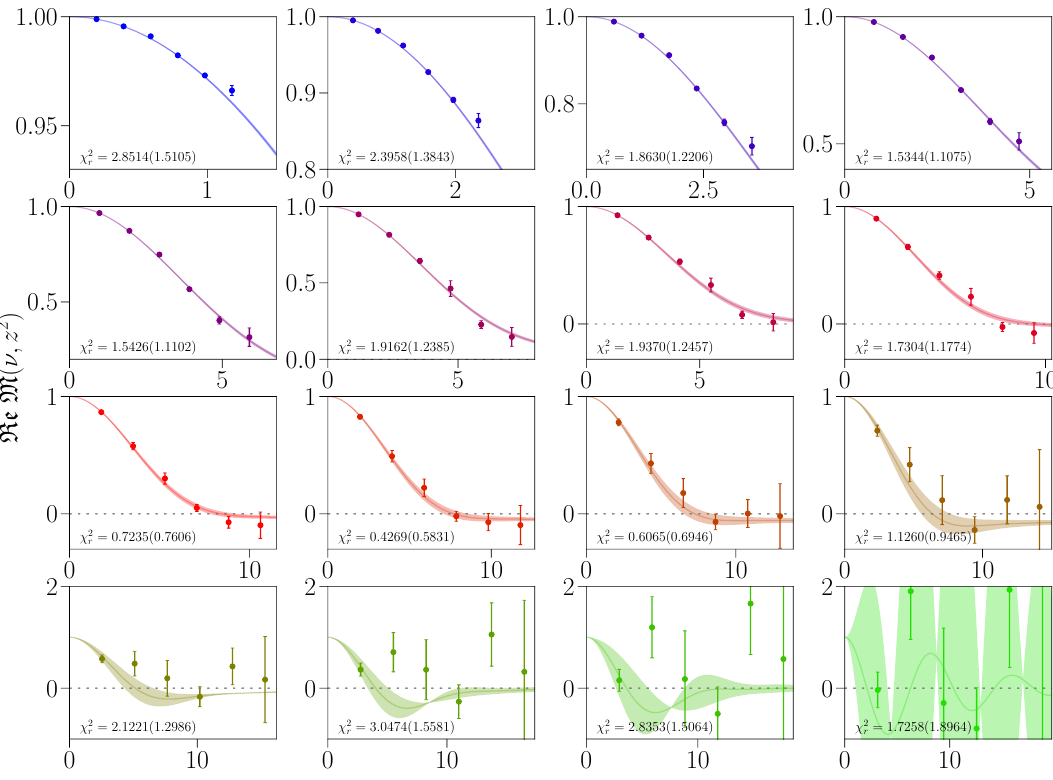
(cid:0) (cid:1) ν, z 2